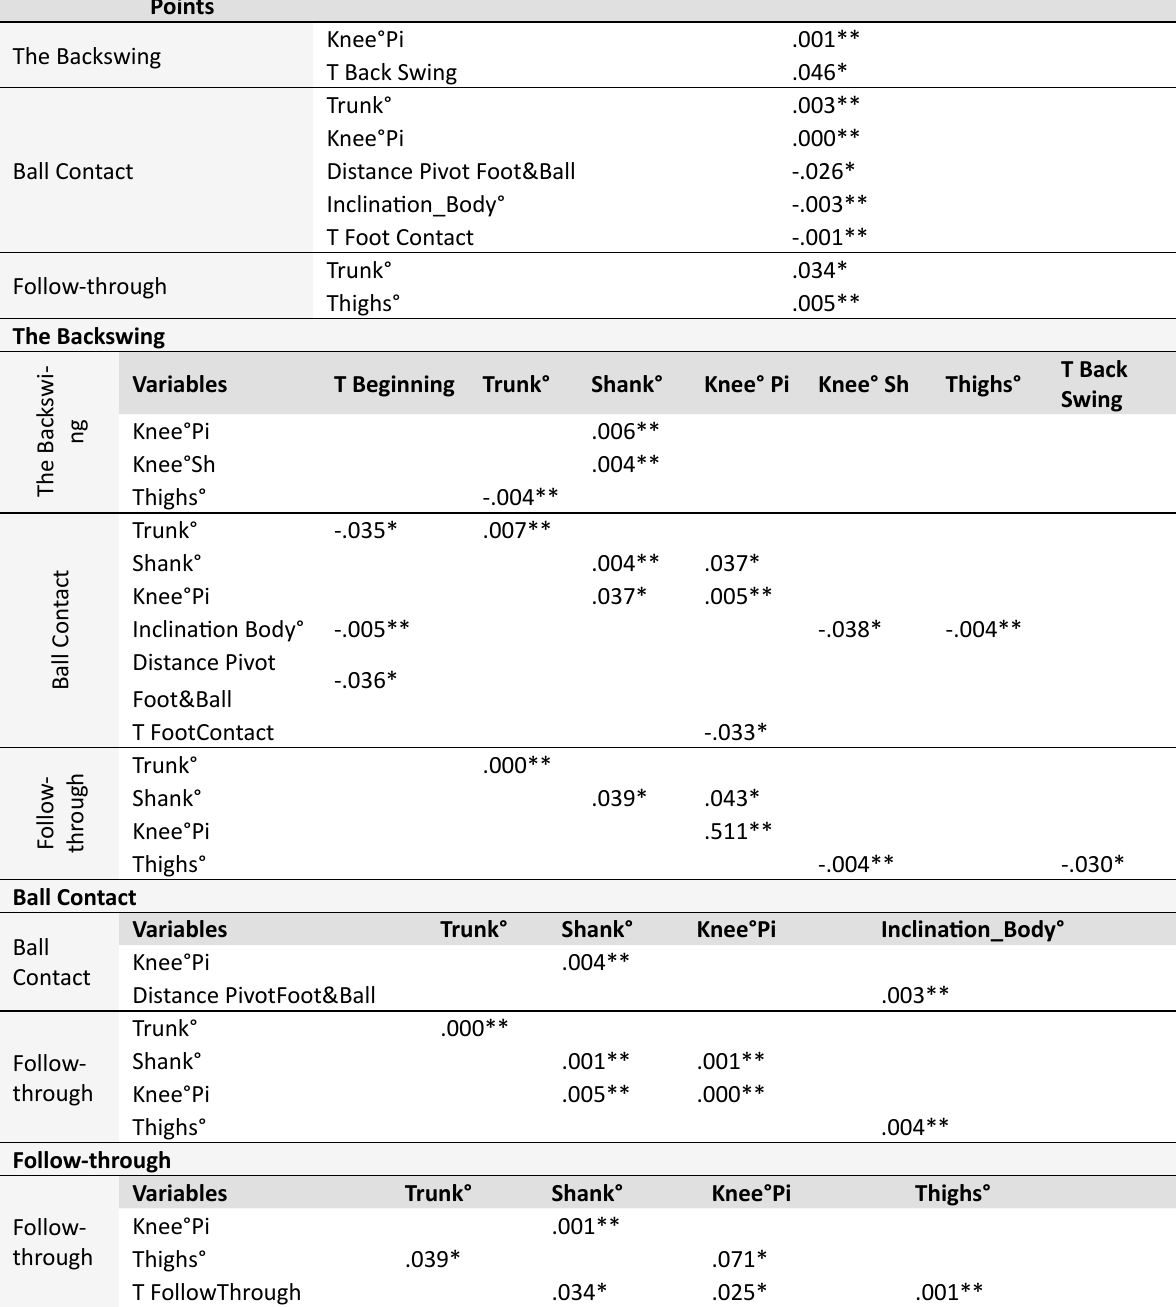
Table 2. The correlation coefficient of